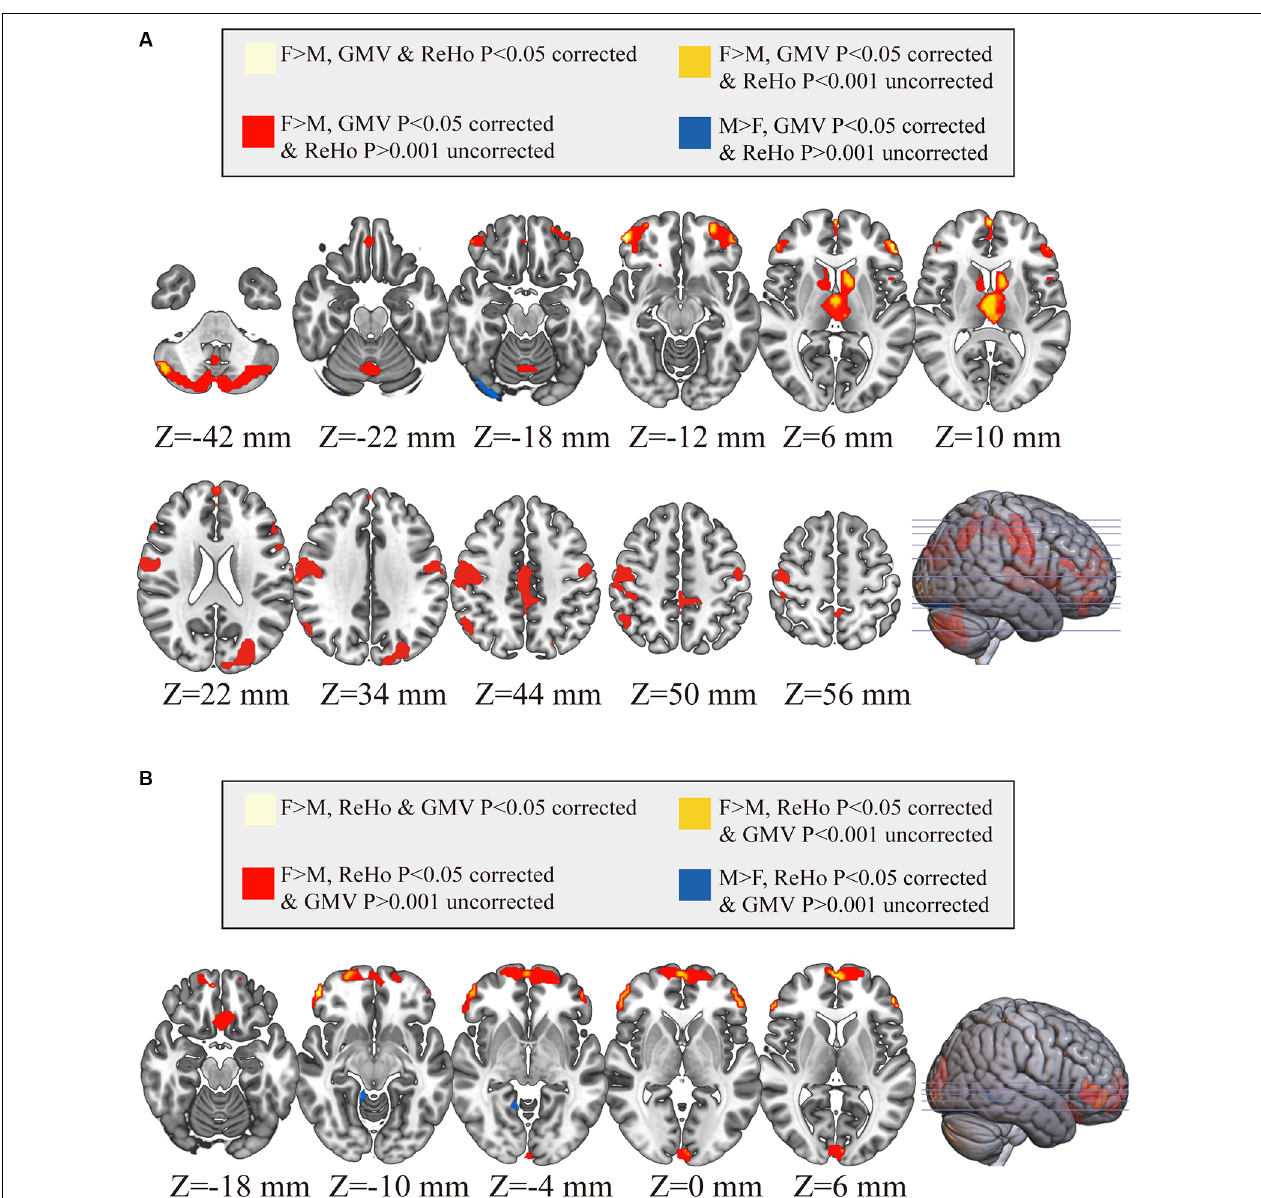
FIGURE 4 | Comparisons between brain areas showing gender differences in GMV and those showing gender differences in ReHo. In Panel (A) , all voxels marked in color show significant gender differences in gray matter volume (GMV; P < 0.05 corrected; warm colors: females > males; cold color: males > females), within which the voxels in light yellow also show significant gender differences in ReHo ( P < 0.05 correct; females > males), the voxels in orange show only a trend of gender differences in ReHo ( P < 0.001 uncorrected; females > males) and the voxels in red (females > males for GMV) and blue (males > females for GMV) show no difference in ReHo ( P > 0.001 uncorrected). In Panel (B) , all voxels marked in color show significant gender differences in ReHo ( P < 0.05 corrected; warm colors: females > males; cold color: males > females), within which the voxels in light yellow also show significant gender differences in GMV ( P < 0.05 correct; females > males), the voxels in orange show only a trend of gender differences in GMV ( P < 0.001 uncorrected; females > males) and the voxels in red (females > males for ReHo) and blue (males > females for ReHo) show no difference in GMV ( P > 0.001 uncorrected). F, female; M,